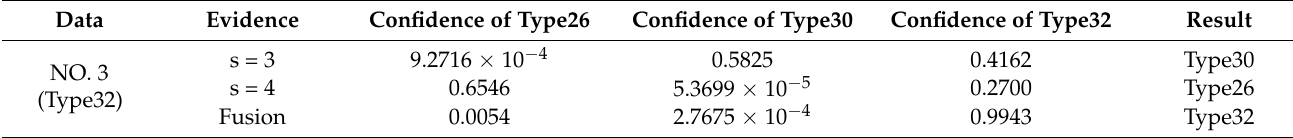
Table 6. Fusion results of misclassification data at two scales.